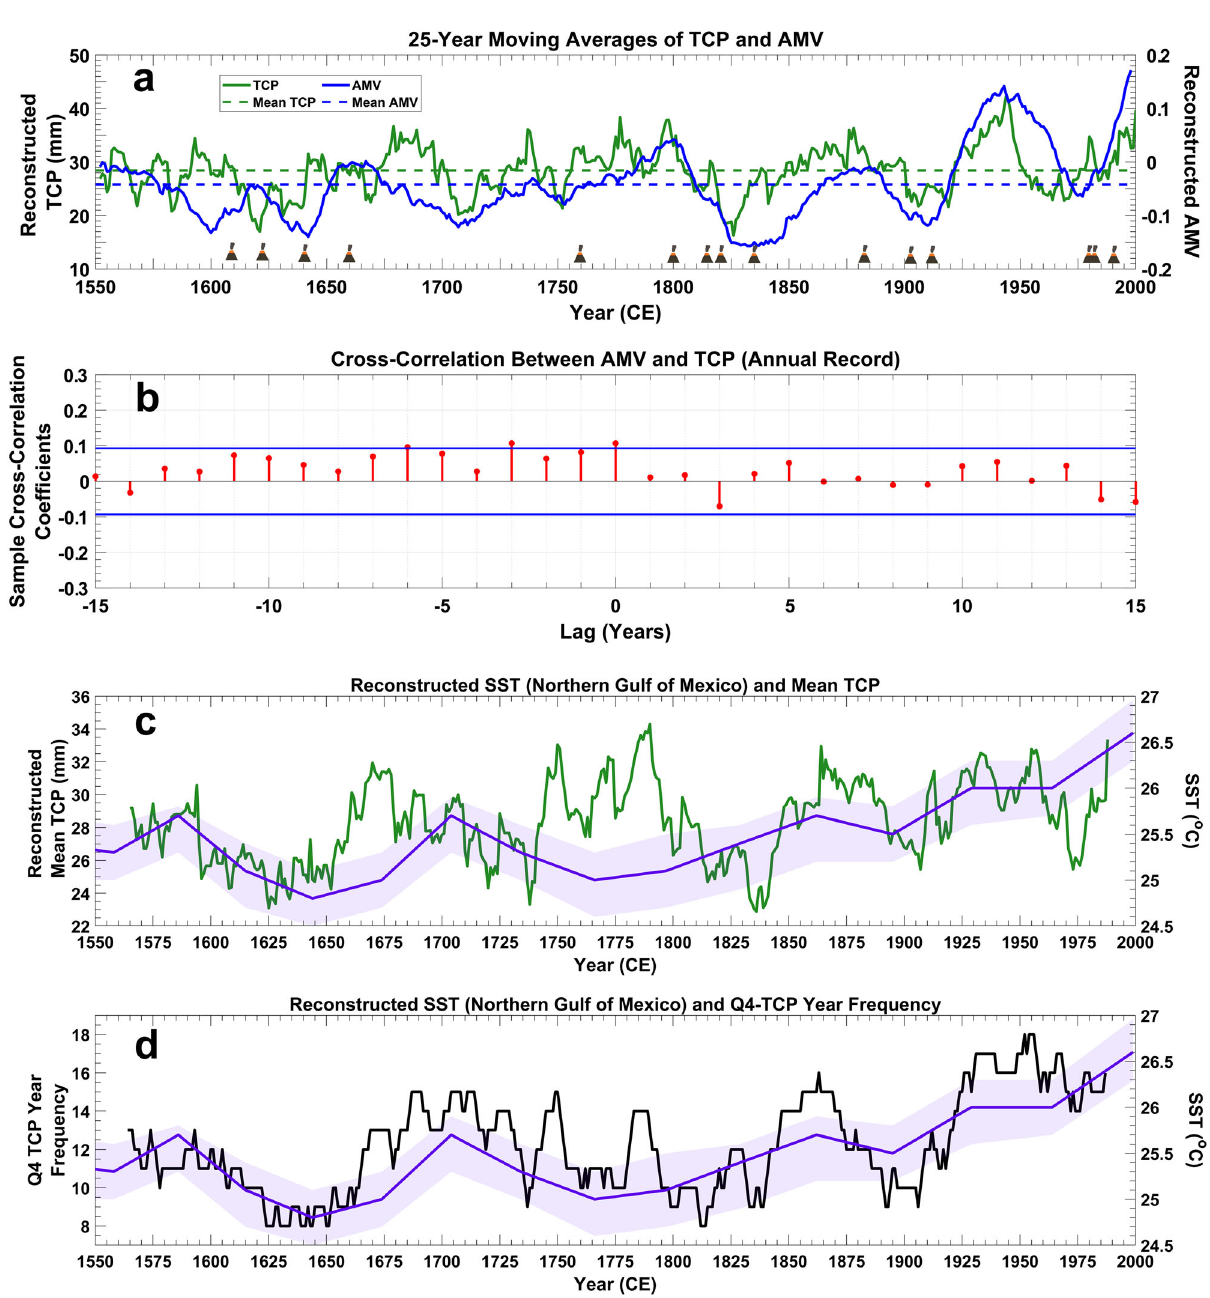
Fig. 4 Multidecadal climate controls of TCP. a Time series of reconstructed tropical cyclone precipitation (TCP; green line) and Atlantic multidecadal variability (AMV; blue line) 53 from 1540 to 2010 using a 25-year moving average. Volcano symbols mark the timing of eruption events included in the superposed epoch analysis (Supplementary Table 3). Green and blue dashed lines are the mean TCP and AMV, respectively. b Cross-correlation coef fi cients (red lines) between detrended annual values of TCP and AMV extending to lag ±15. Blue lines represent the signi fi cance threshold, which were corrected for autocorrelation following Cryer and Chan (ref. 92 ) and Dean and Dunsmuir (ref. 93 ). c Time series of reconstructed seasonal (July – September) mean TCP totals (green line; left axis; mm) and the Loop Current as represented by SSTs from the northern Gulf of Mexico (lavender line; right axis; °C) 100 . Mean TCP was calculated using a 50-year moving average. Lavender shading represents the 95% con fi dence intervals for SSTs. d Same as in a but using the frequency of years with TCP totals reaching the fourth quartile ( ≥ 42.2 mm; Q4; black line; left axis). Q4 frequency was calculated using a 50-year moving